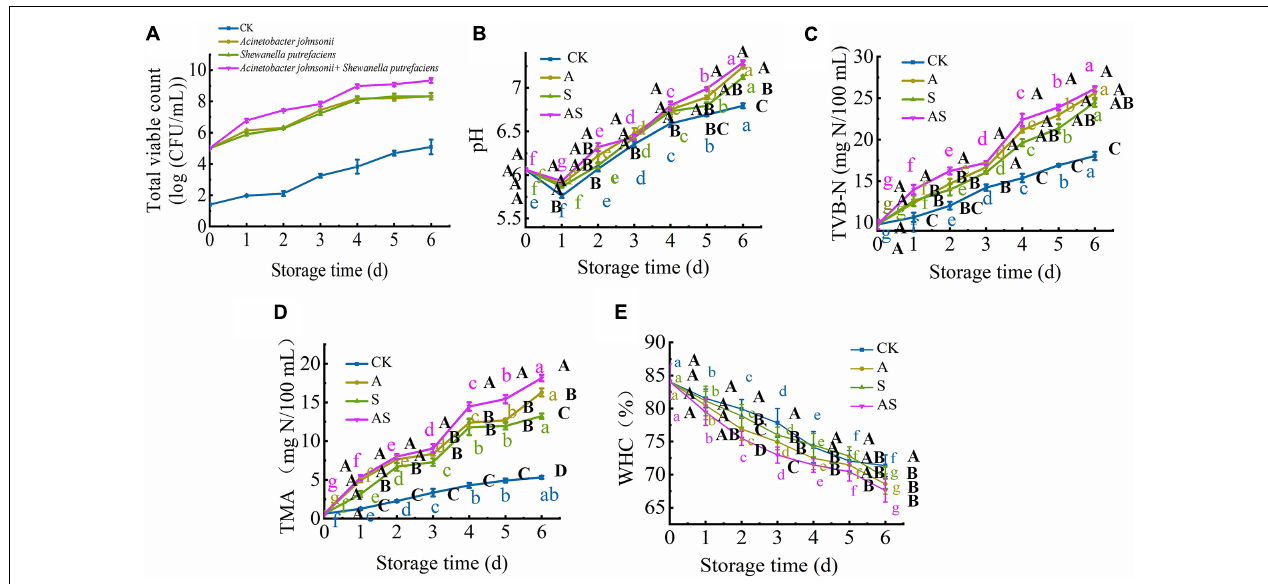
FIGURE 1 | Changes in the total viable count (TVC) (A) , pH (B) , total volatile base nitrogen (TVB-N) (C) , trimethylamine (TMA) (D) and water holding capacity (WHC) (E) in bigeye tuna with different bacterial groups stored at 4 ◦ C for 6 days (each point is the mean value of three determinations). Different capital letters denote significant differences ( P < 0.05) among bacterial groups at the same storage time. Different lowercase letters denote significant differences ( P < 0.05) among the different storage times per treatment